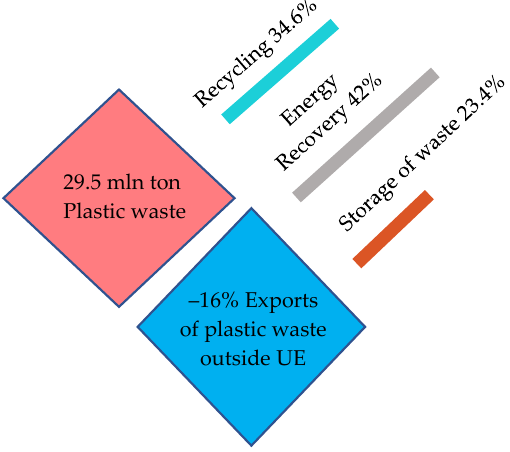
Figure 10. Waste management in 2020. Made based on [3].